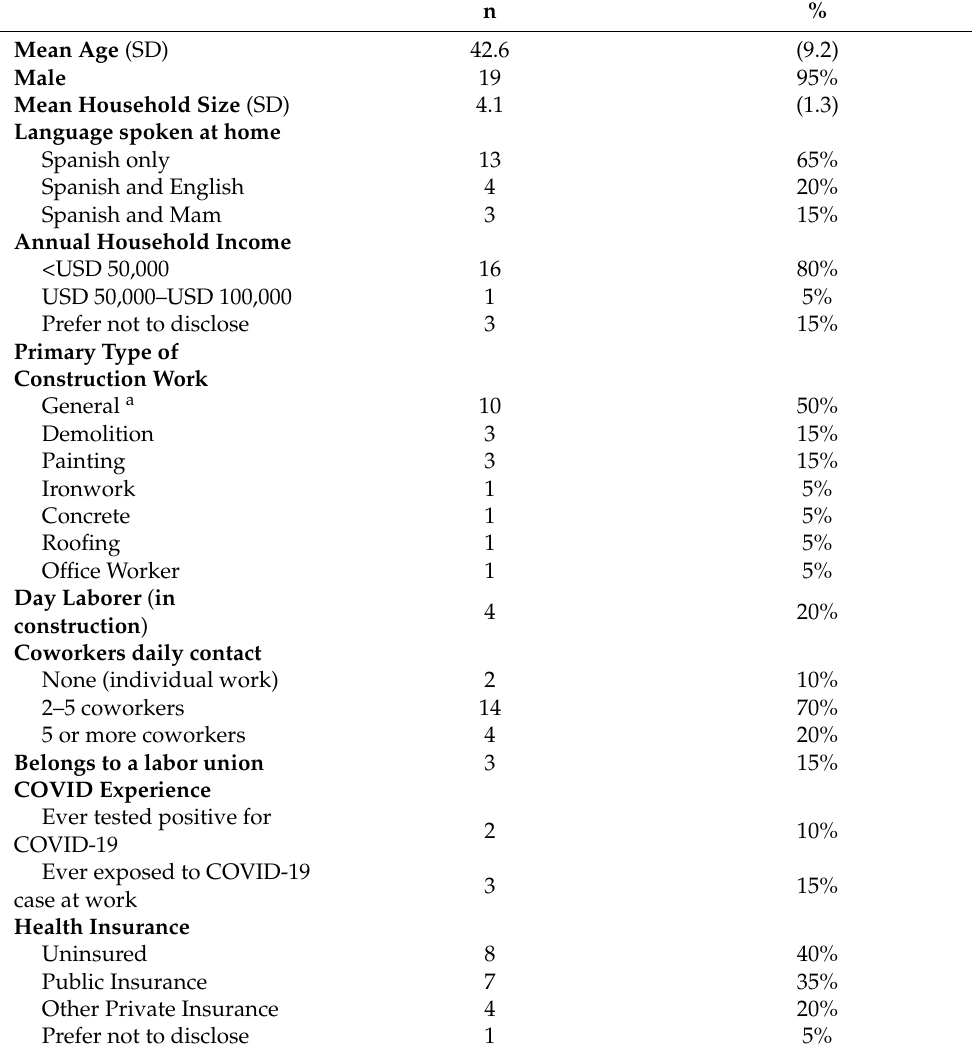
Table 1. Sample Characteristics of Latino participants interviewed (N =